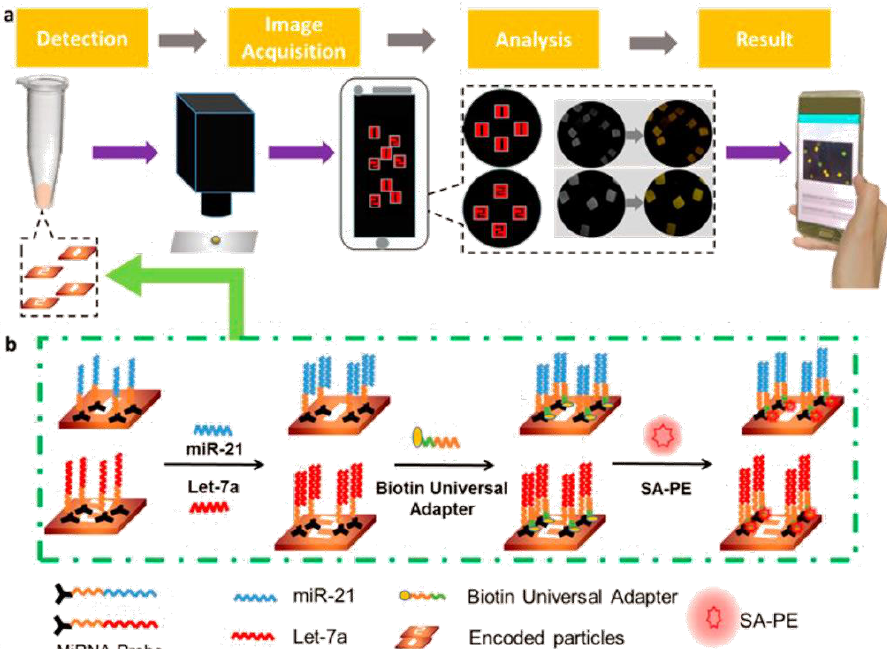
Figure 2. ( a ) Schematic illustration of how miRNA (miR-21, let-7a) can be detected utilizing hydrogel microparticles that have been encoded with certain shapes using a smartphone detection platform. To learn more about the kind and concentration of the miRNA, the liquid system was moved to a solid substrate after the sandwich structure formation. ( b ) Images were then taken using a self-made POCT device and analyzed using Android software. Reprinted with permission from Ref. [59]. Copyright 2019, American Chemical Society.